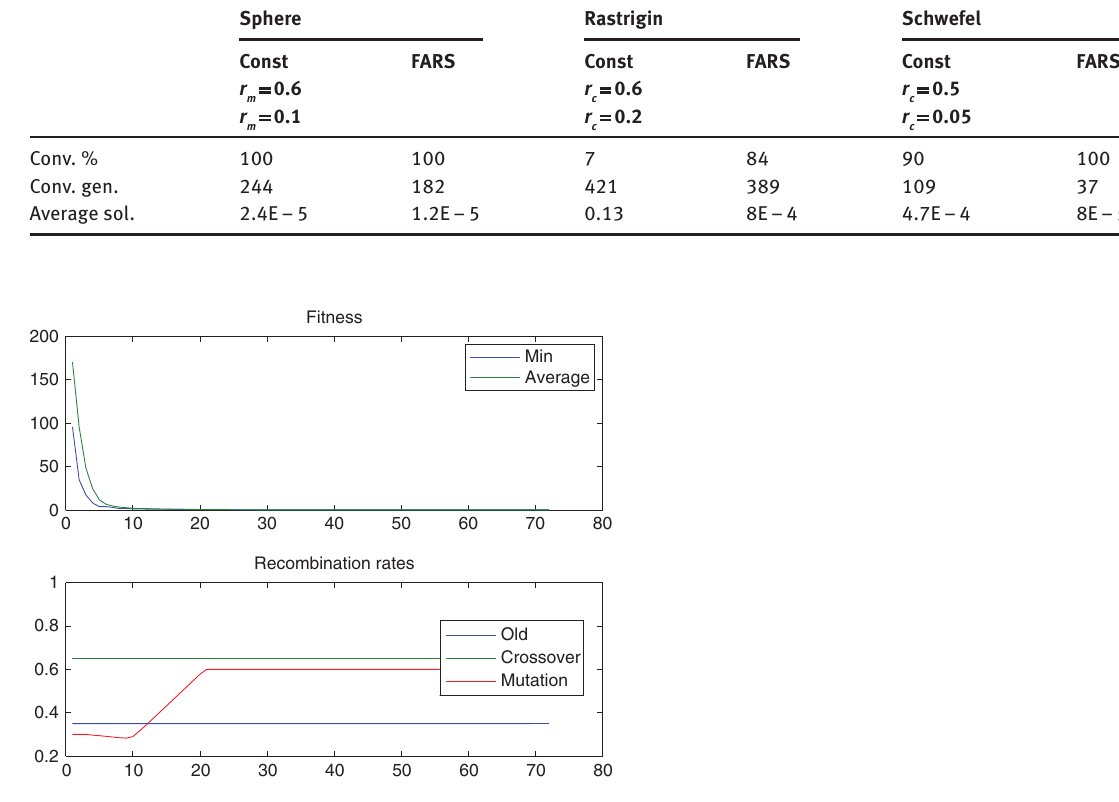
Table 2: Results Obtained on the Function Minimization Problems: The Best ( r Reported. Sphere Rastrigin Schwefel